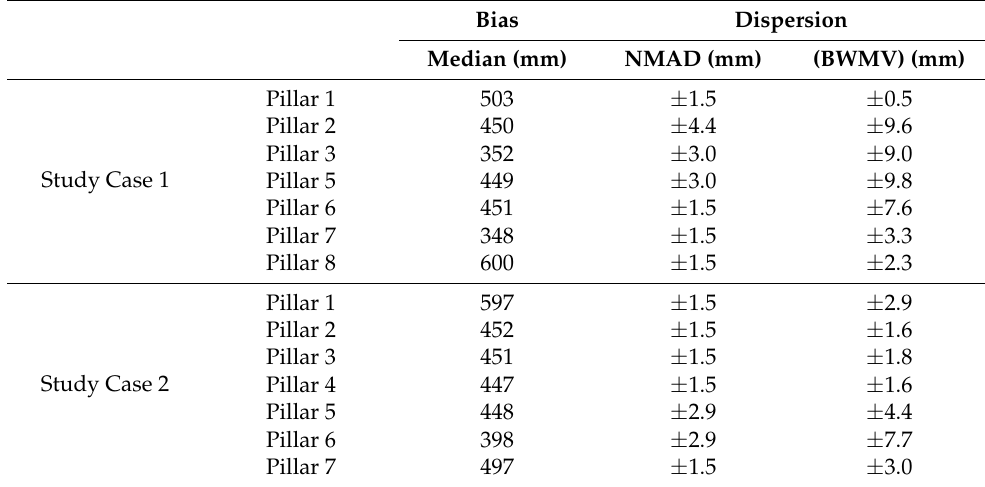
Table 6. Bias and dispersion data for the analysed data in both study